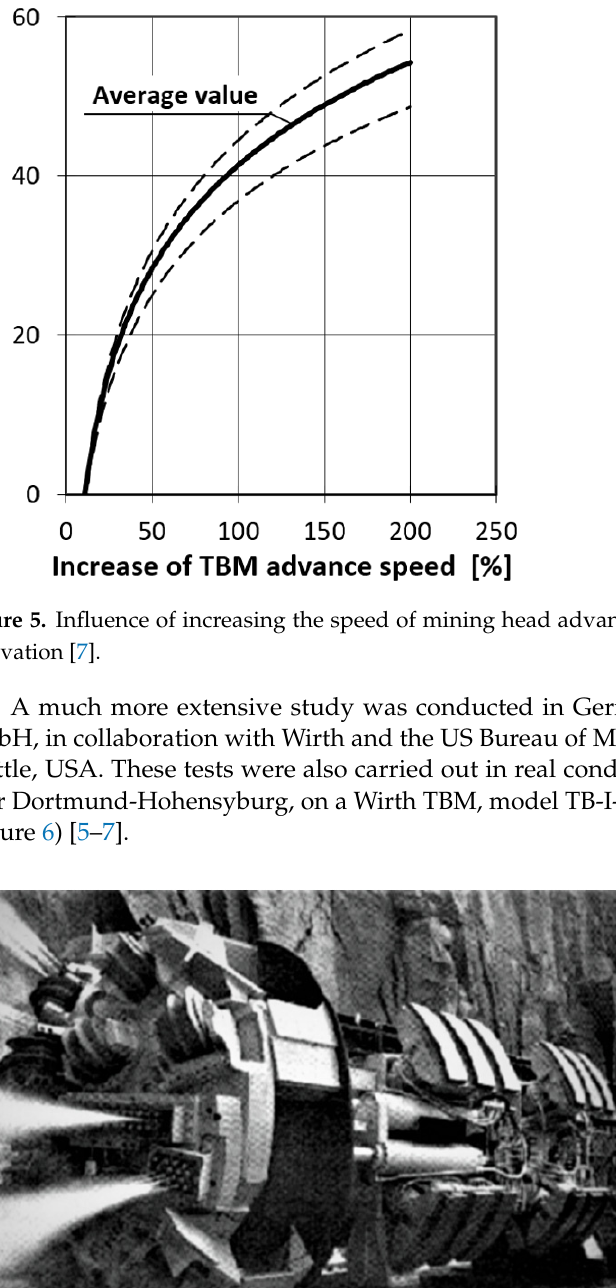
Figure 6. View of a Wirth TBM, model TB-I-260, with HPW jet assistance [7].